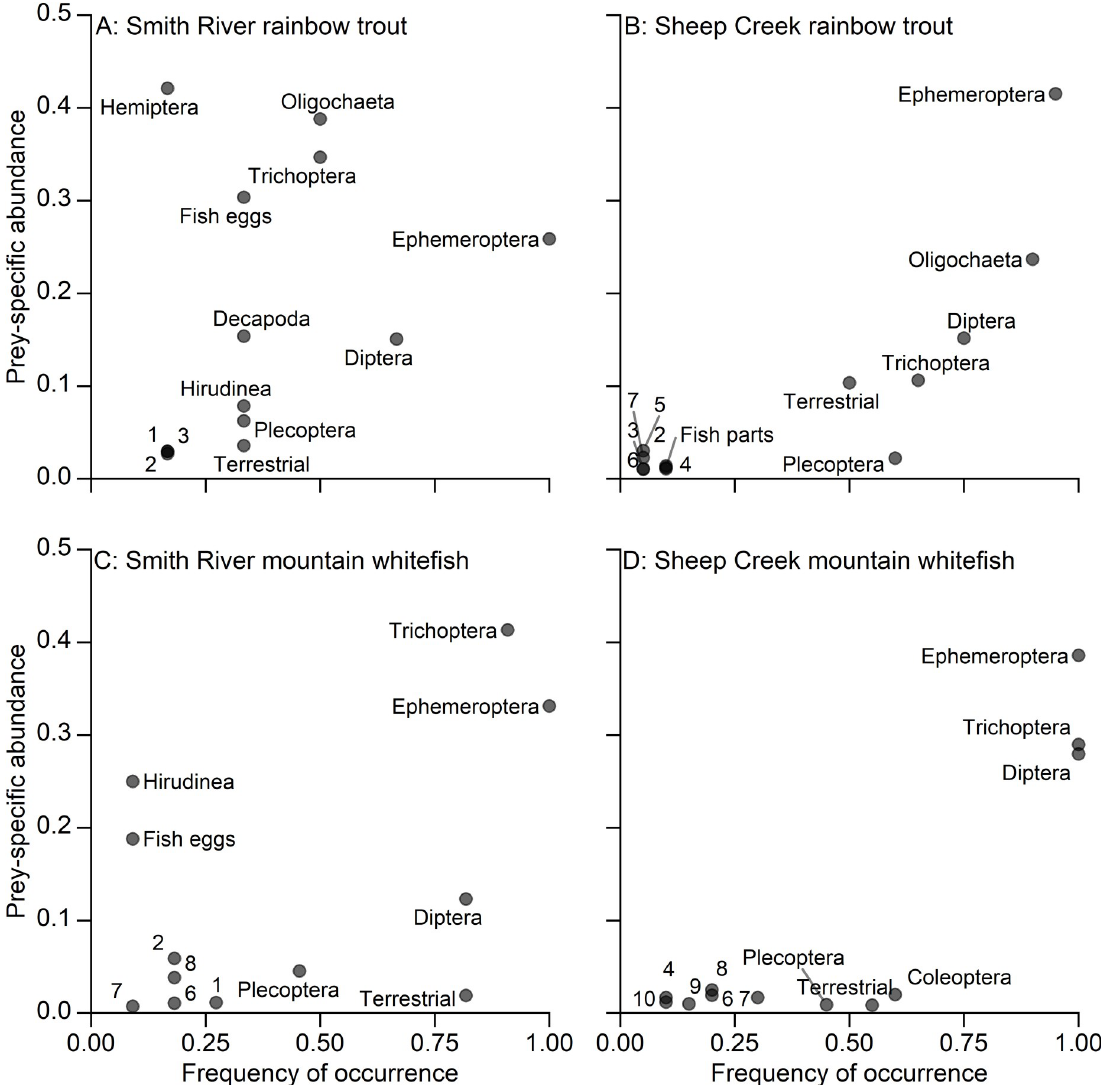
Fig 4. Feeding strategy diagram. Feeding strategy diagram of the modified Costello method according to Amundsen et al. (1996) [31]. Prey-specific abundances and frequencies of occurrence in the diets of mountain whitefish (MW) and rainbow trout (RB) in the Smith River and Sheep Creek. Numbered diet categories are 1: Fish larvae; 2: Coleoptera; 3: Amphipoda; 4: Scorpaeniformes; 5: Hemiptera; 6: Gastropoda; 7: Diptera pupae; 8: Oligochaeta; 9: Acari; 10: Neuroptera. Panels show (A) rainbow trout in the Smith River; (B) rainbow trout in Sheep Creek; (C) mountain whitefish in the Smith River; and (D) mountain whitefish in Sheep